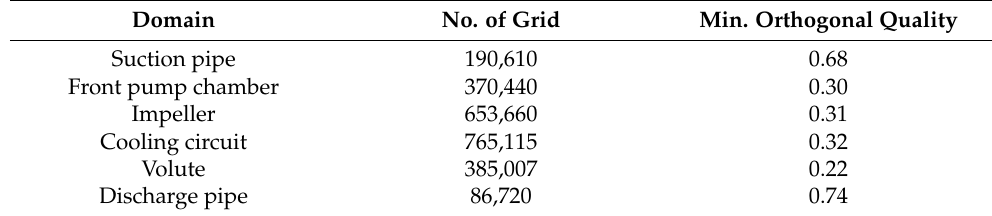
Figure 6. Mesh of the computational domain. Table 3. Mesh information of the computational domain.